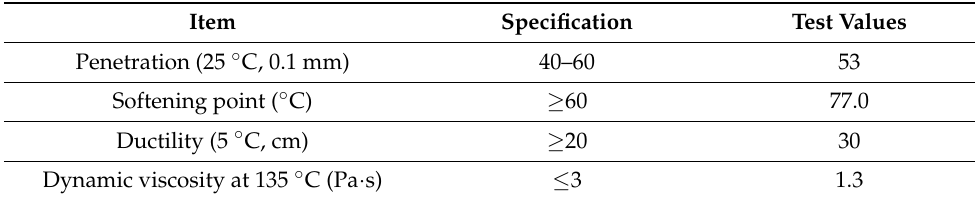
Table 2. Technical indices of the SBS modified asphalt.